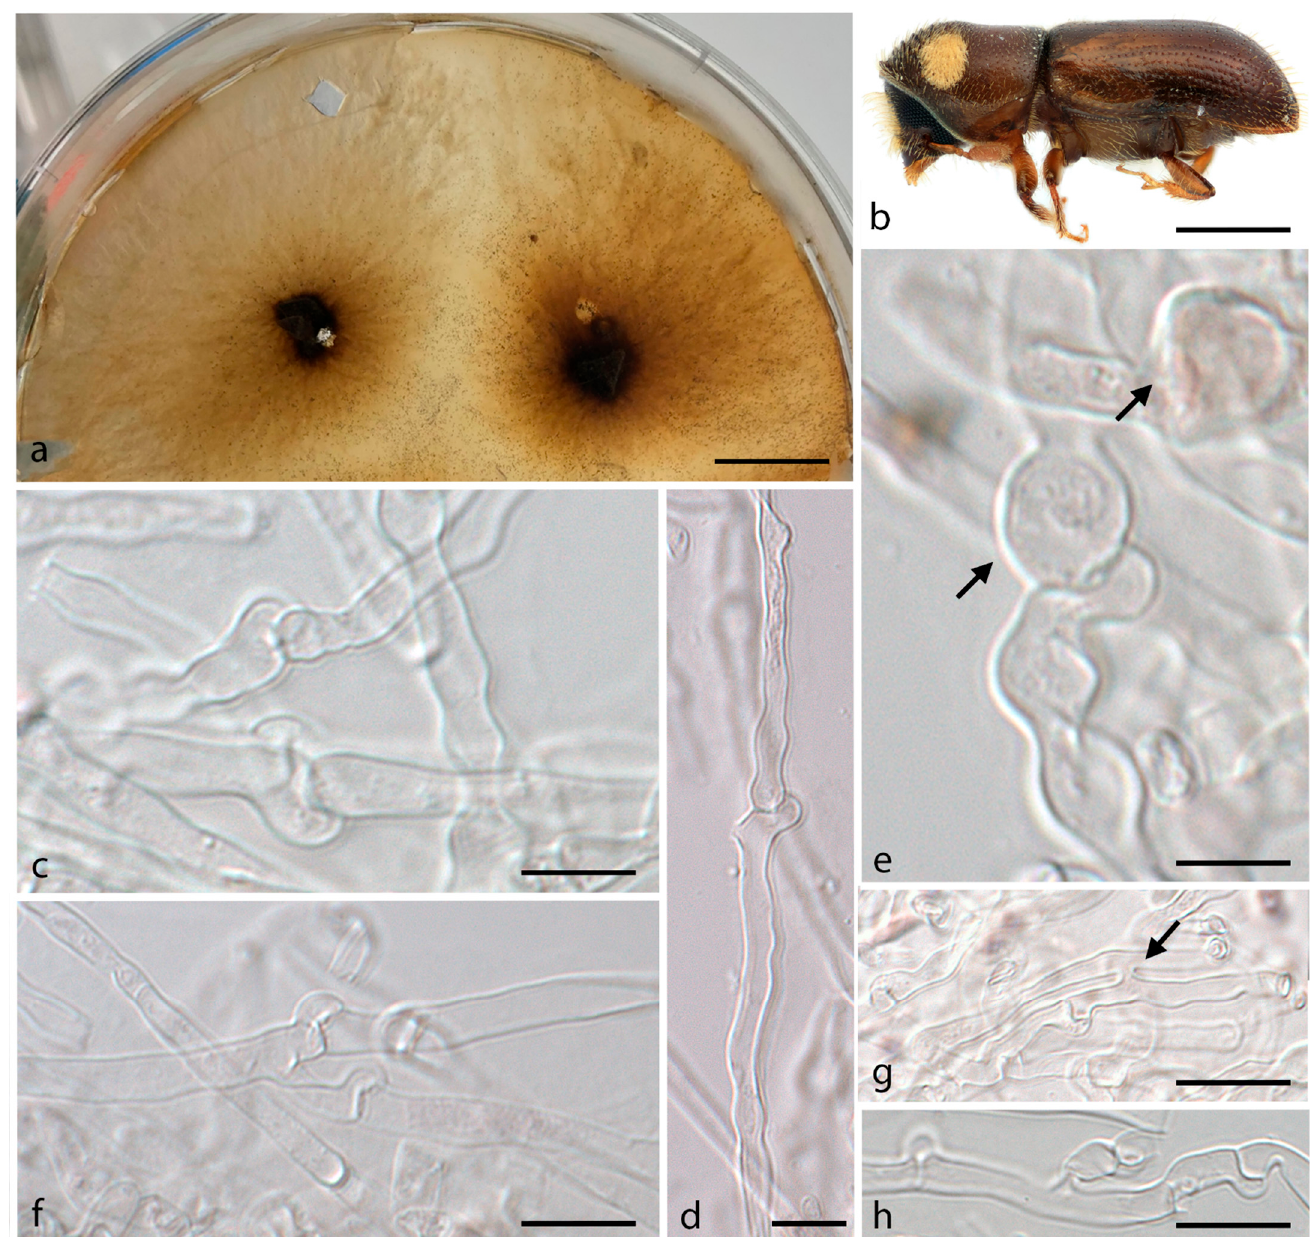
Figure 3. Entomocorticium fibulatum . ( a ) Culture aspect on PDA plate; ( b ) The beetle vector Pityoborus comatus ; ( c , d ) Clamp connections; ( e ) Early stage of chlamydospores formed by a clamp connection (arrows); ( f ) Clamp connections; ( g ) Hyphae anastomosing (arrow); ( h ) Hypha exhibiting regular clamp connections. Scale bars: ( a ) = 2 cm; ( b ) = 0.5 cm; ( c , d ) = 4 µm; ( e – h ) = 5 µm.